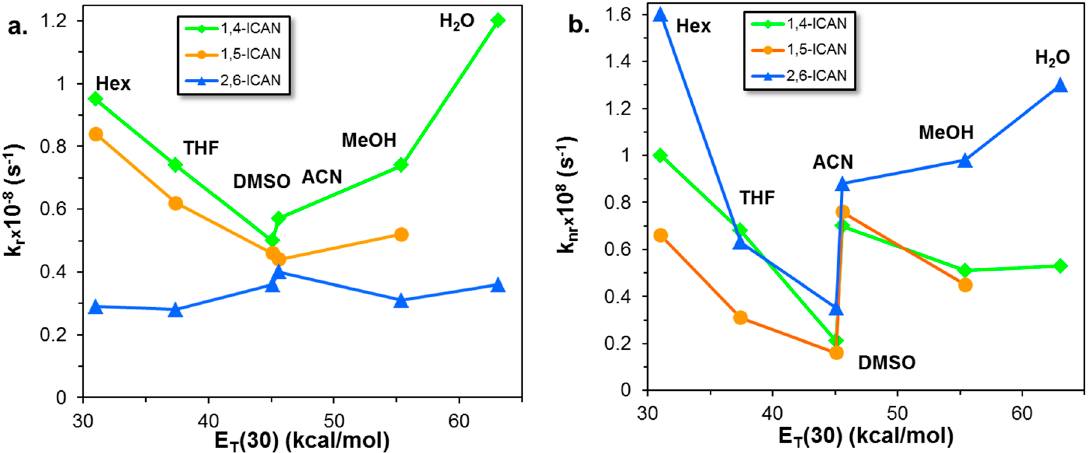
Figure 7. The variation of the radiative decay rate (k r ) ( a ) and the non-radiative decay rate (k nr ) ( b ) the with the empirical solvent polarity parameter E T (30).